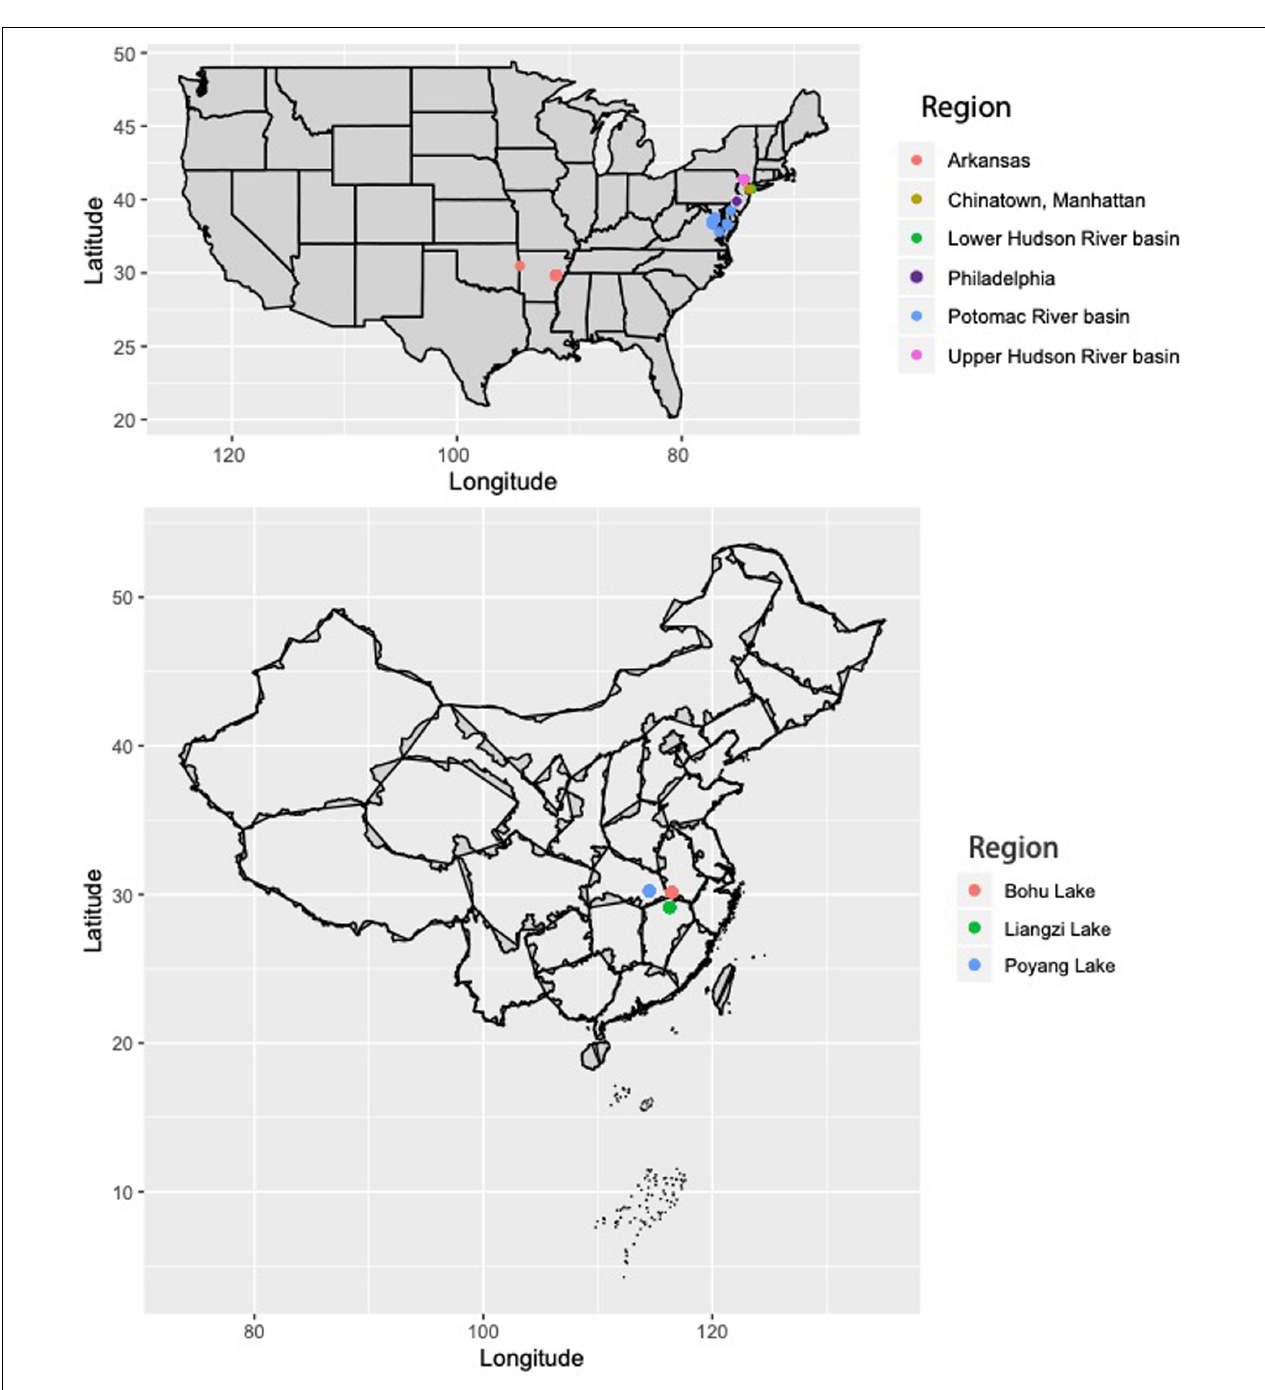
FIGURE 1 | Collection locations for Channa argus individuals in the United States and China. For detailed map of U.S. collections, see Resh et al. (2018) and Supplementary Table 1 .